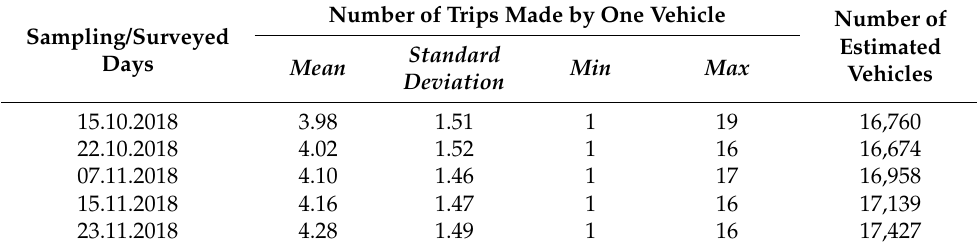
Table 6. Basic statistical attributes of trip